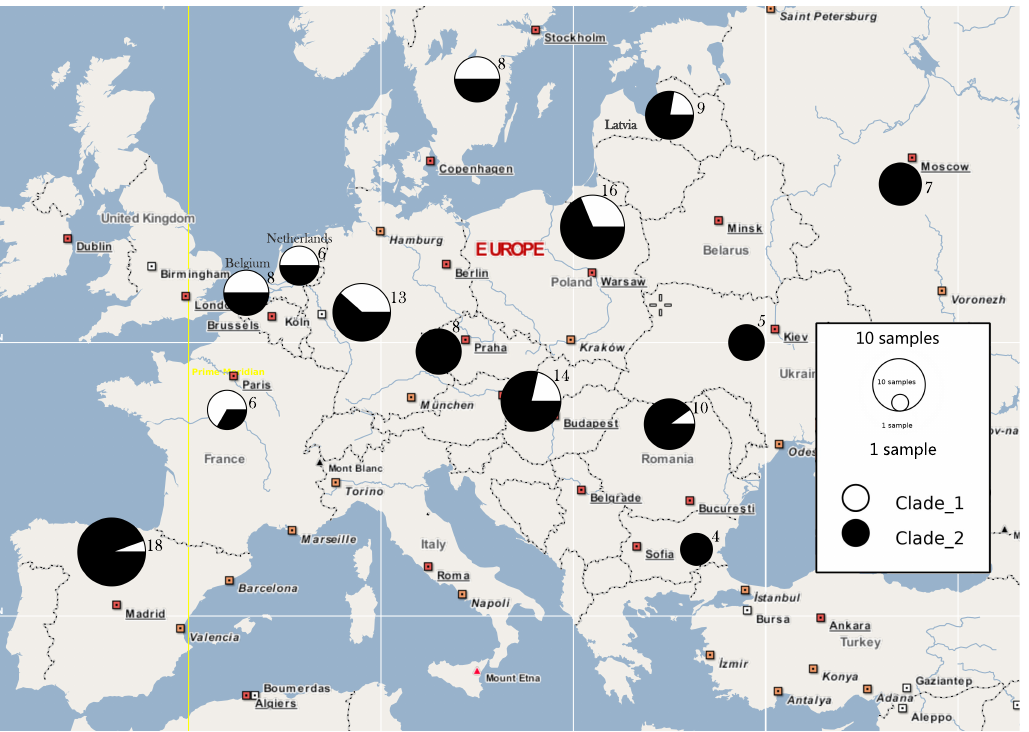
Figure 2. Geographic distribution of the two main haplotype clades, based on concatenated Cytb and CO1 , as represented by our mtDNA data from 132 birds in 14 countries. On the map, the unit near each circle indicates number of samples for the respective population.